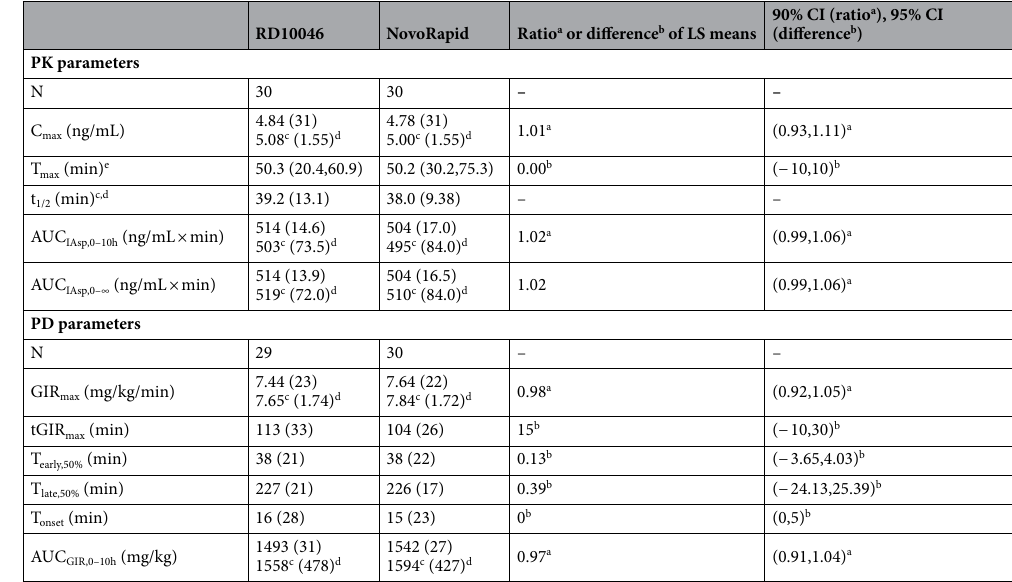
Table 2. Parameters of pharmacokinetics and pharmacodynamics. Values are presented as geometric means and CV (%) unless otherwise indicated. AUC 0–10h area under the curve from time 0 to 10 h, AUC 0–∞ area under the curve from zero to infinity, CI confidence interval, C max maximum observed drug concentration, CV coefficient of variation, GIR glucose infusion rate, h hours, LS least squares, N number of subjects, GIR max maximum glucose infusion rate, T max time of maximum observed drug concentration, tGIR max time of maximum glucose infusion rate, T early,50% and T late,50% time of half-maximum GIR before and after GIR max , T onset first time of the blood glucose declining down to the target level (0.28 mmol/L less than the baseline). a Ratio of LS means (RD10046 divided by NovoRapid). b Difference between medians (RD10046—NovoRapid). c Arithmetic mean. d Standard deviation. e Median (range).